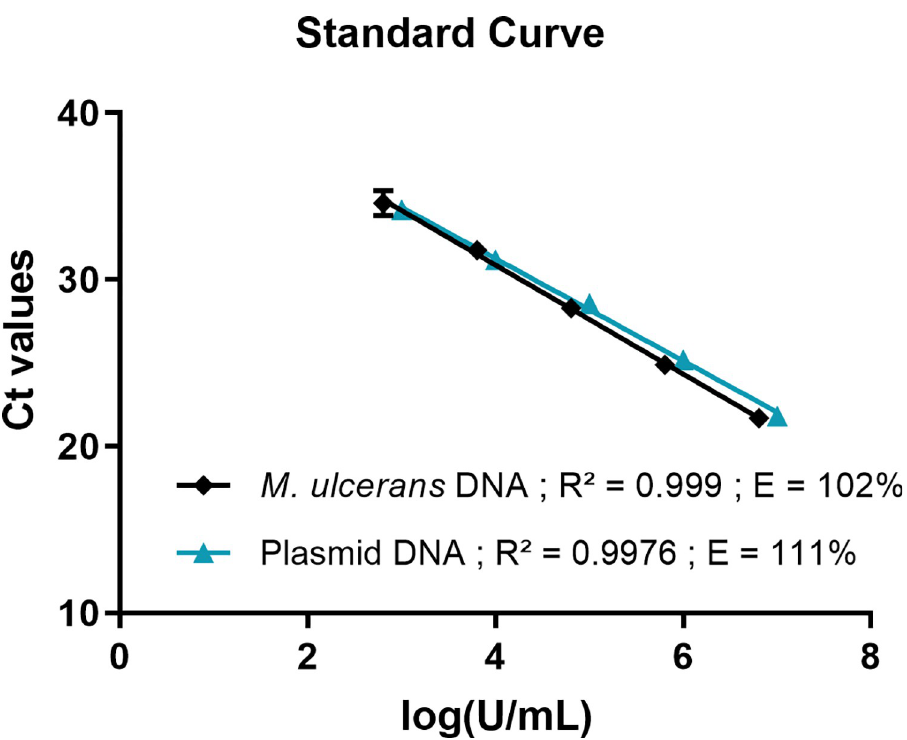
Fig 5. Comparison of internal positive control: Standard curve for IS 2404 . Serial 10-fold dilution from 6,4x10 6 U/ mL to 6.4x10 0 U/mL of M . ulcerans DNA (in black). Serial 10-fold dilution from 1x10 7 U/mL to 1x10 0 U/mL of plasmid DNA (in blue). The standard curve was generated by a linear regression of the threshold cycle (Ct) against the logarithm of DNA concentration. Each 10-fold dilution was performed in duplicate, one standard deviation (SD) is shown. M . ulcerans DNA standard curve ( y = − 3.271 x + 43.96); Plasmid standard curve ( y = − 3.074 x +